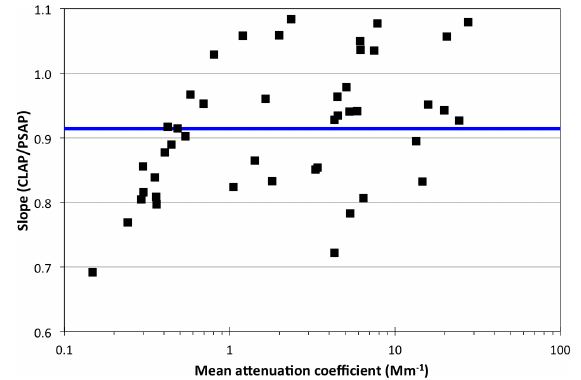
Figure 11. Slope of orthogonal regression line relating attenuation coefficients measured by CLAP vs. PSAP as a function of mean attenuation coefficient for 17 stations. The blue line indicates the median slope of 0.914. Data are given for all measured